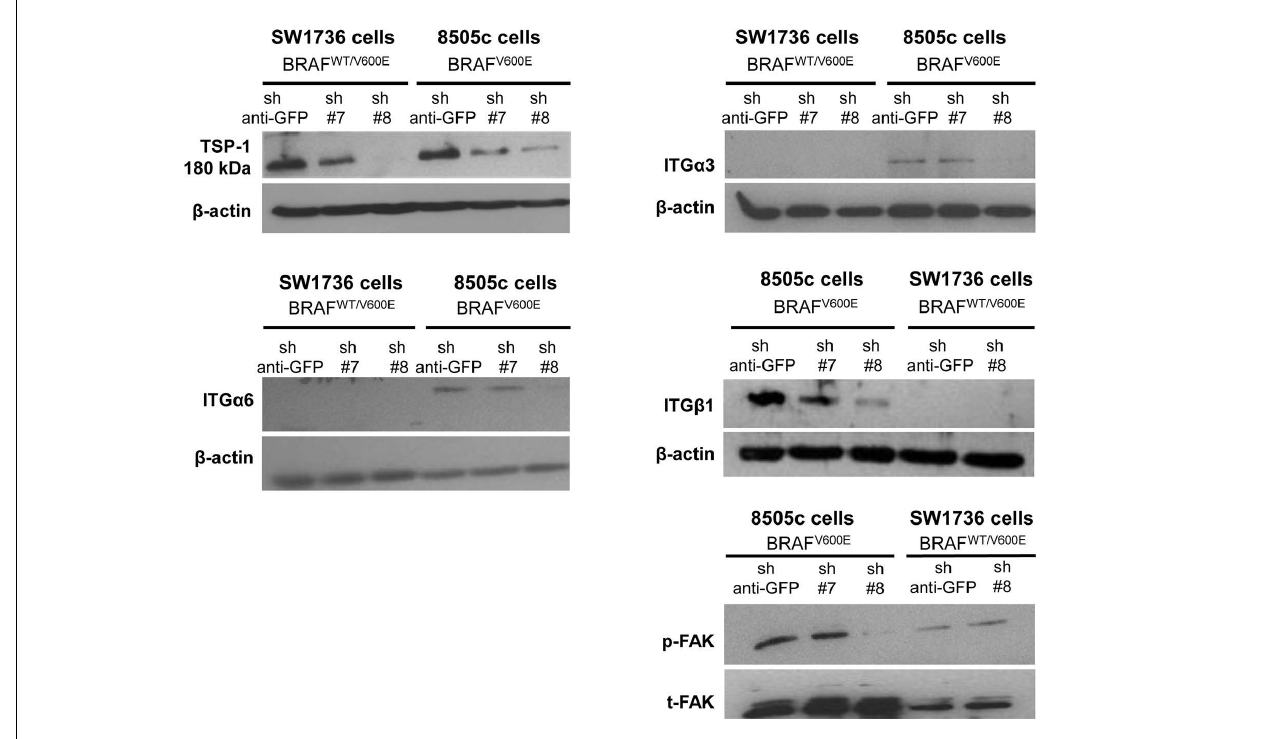
FIGURE 1 | TSP-1, ITG α α β